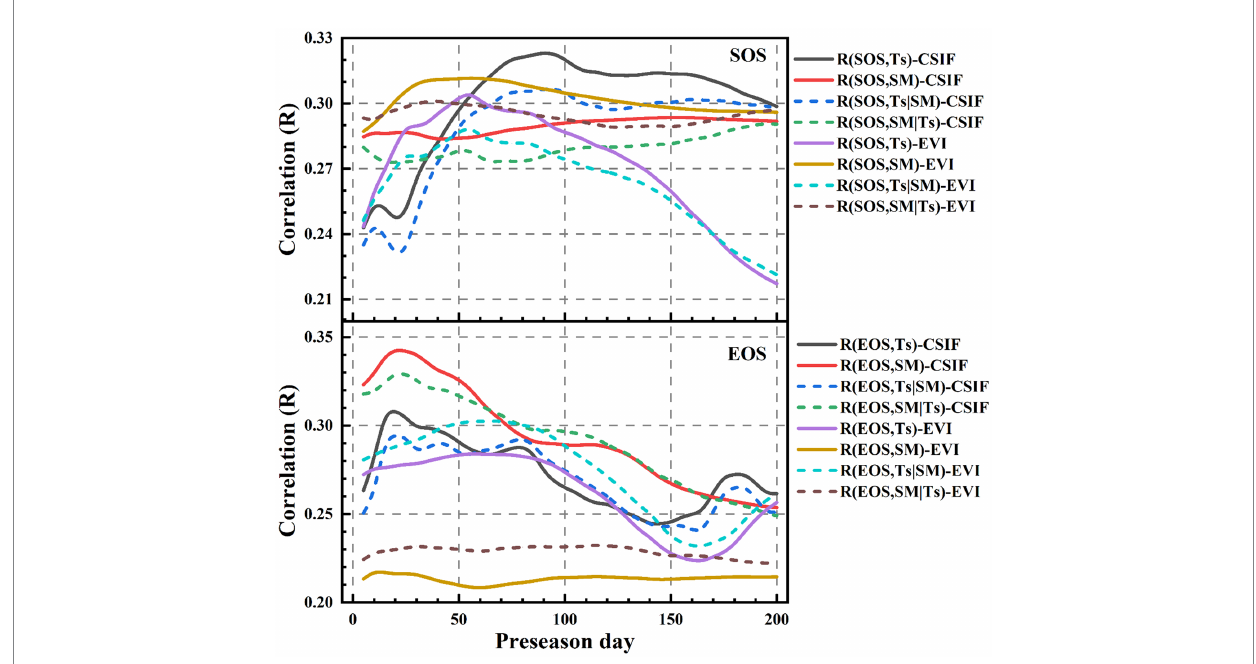
FIGURE 6 Correlation coefficients and partial correlation coefficients between CSIF, EVI derived SOS, EOS, respectively and pre-season Ts, SM over